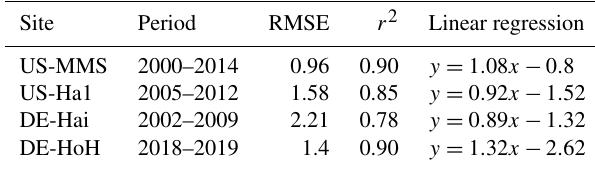
Table 5. Summary statistics for the comparison between model- estimated LAI and field measurement LAI at different sites. Statis- refer to ensemble medians of model-estimated